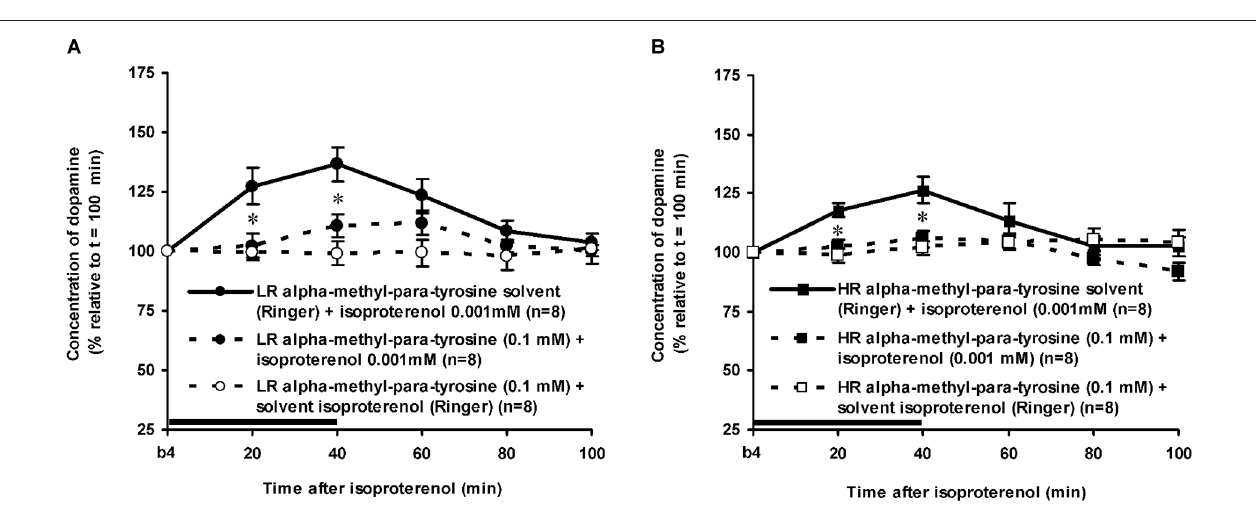
collected just before ISO was infused (basal sample b4 of Figure 3 ). Data are expressed as mean percentage ± SEM. The solid horizontal line represents the infusion time of ISO. * AMPT-induced reduction of the ISO-induced DA increase (Student’s t -